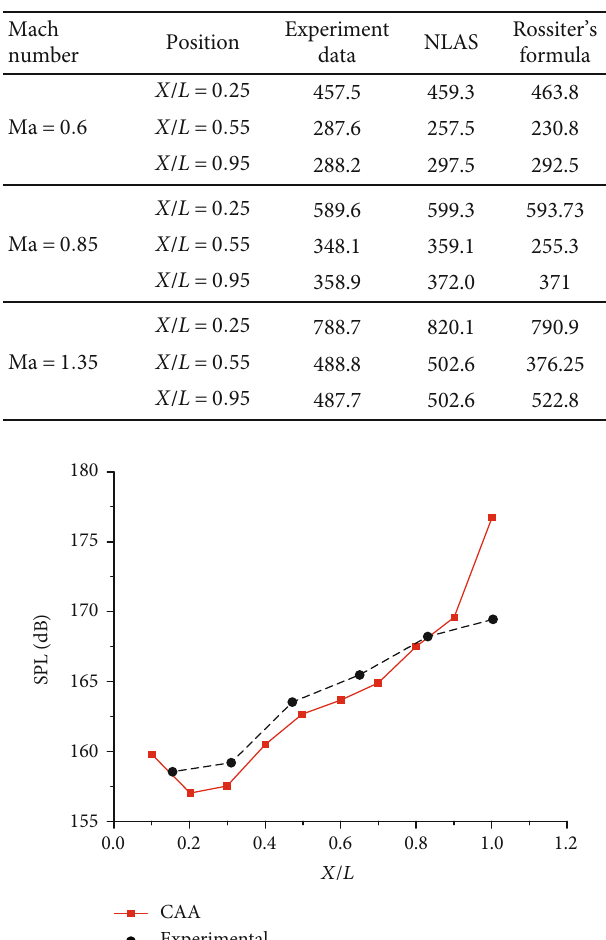
Table 2: Comparison of dominant frequency locations (Hz).